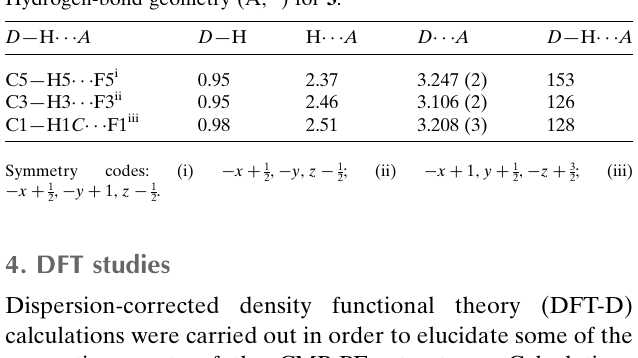
Table 3 Hydrogen-bond geometry (A˚ , (cid:4) ) for 3 .